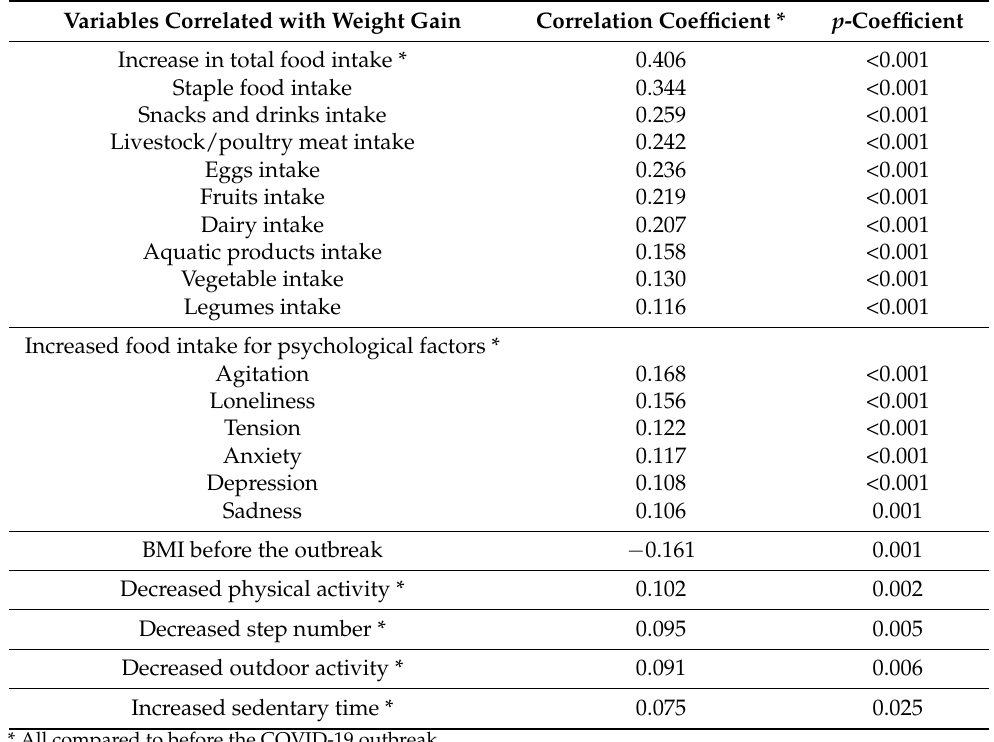
Table 7. Variables correlated with weight gain, listed in order by the correlation coefficient. Variables Correlated with Weight